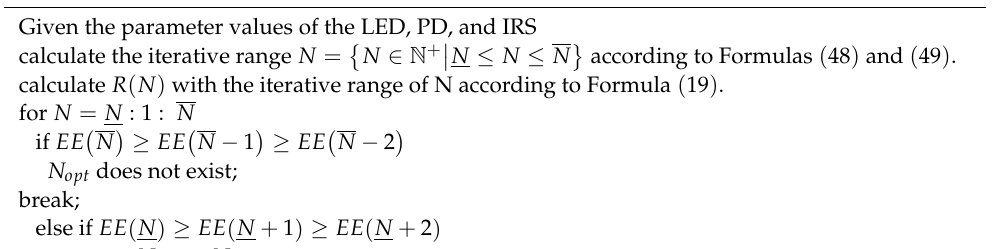
Algorithm 2: The BSCI